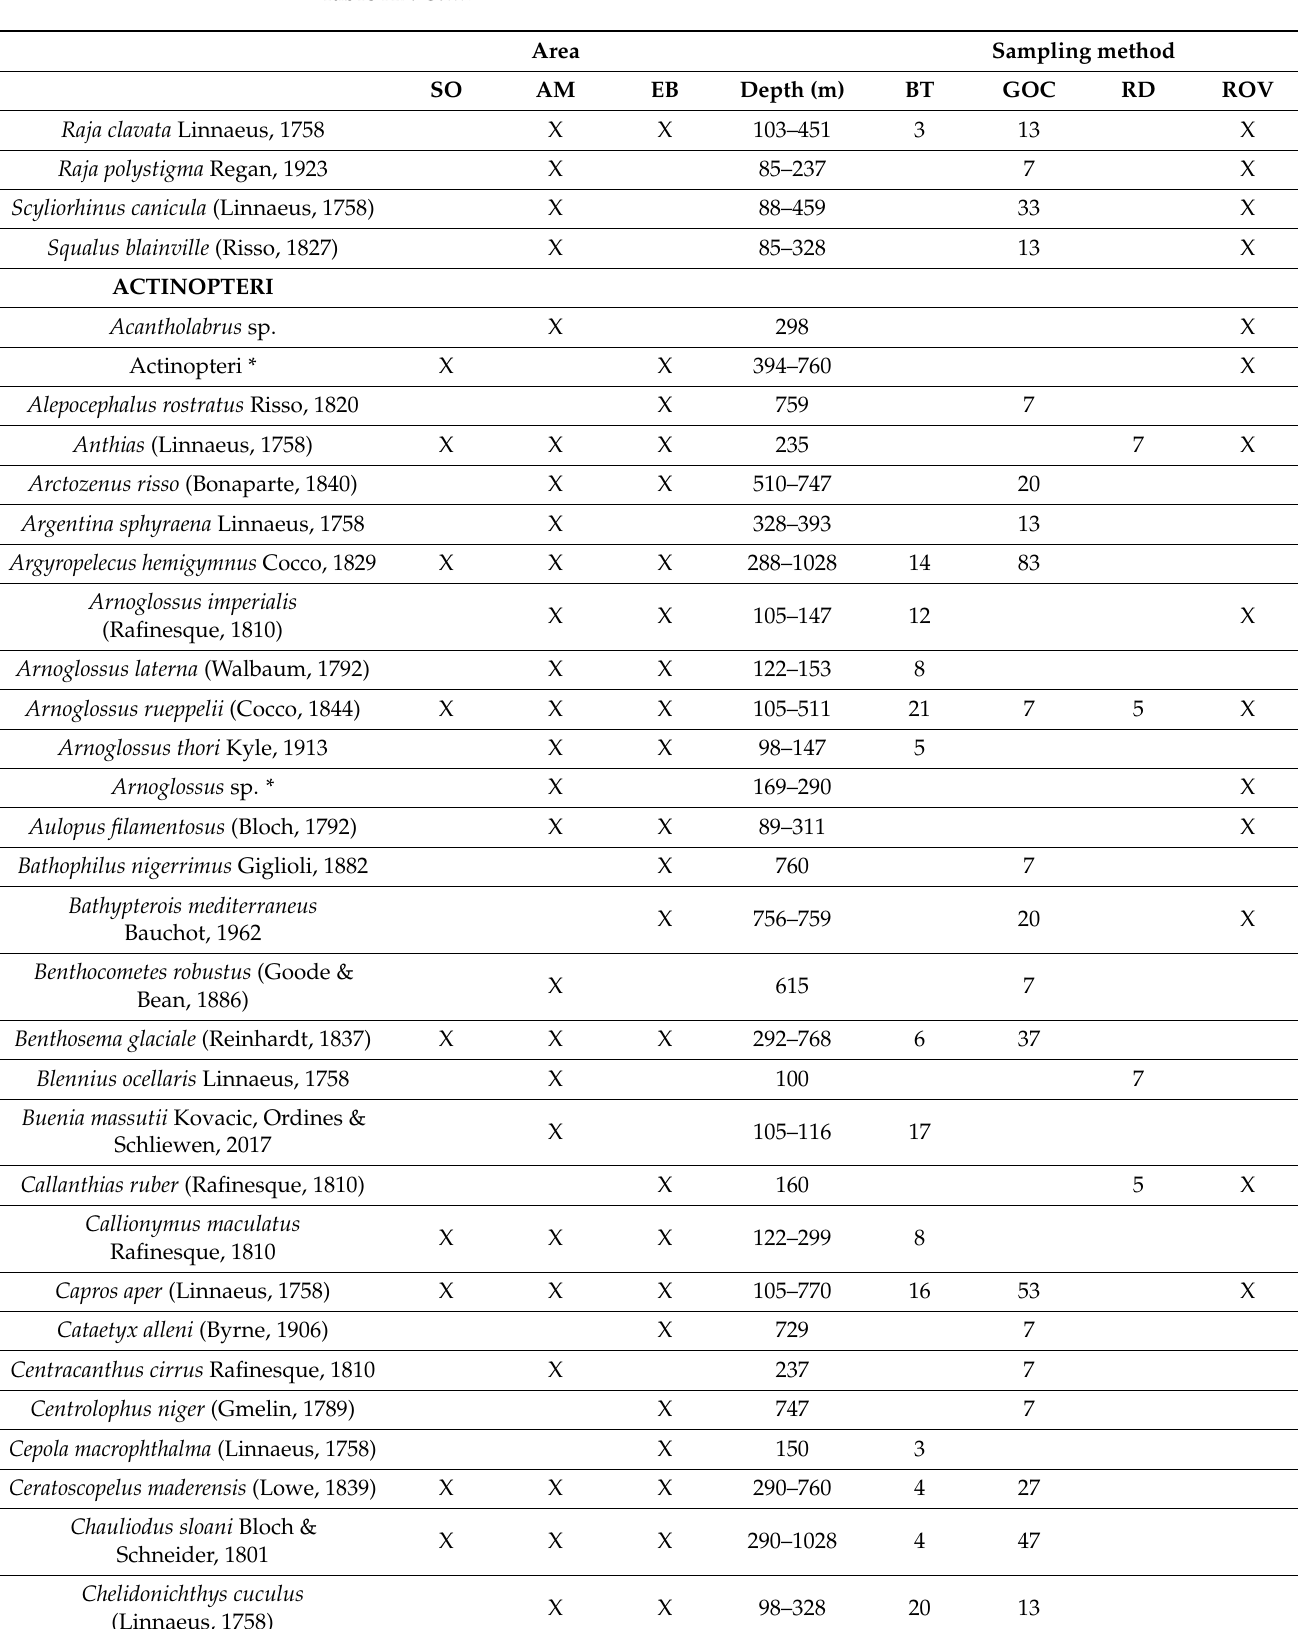
Table A7. Cont. Area Sampling